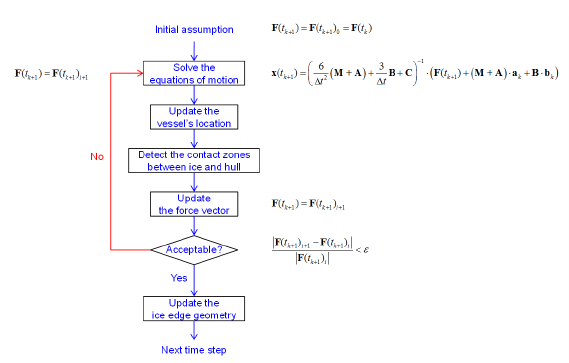
Figure 4: Flow chart of the numerical procedure.